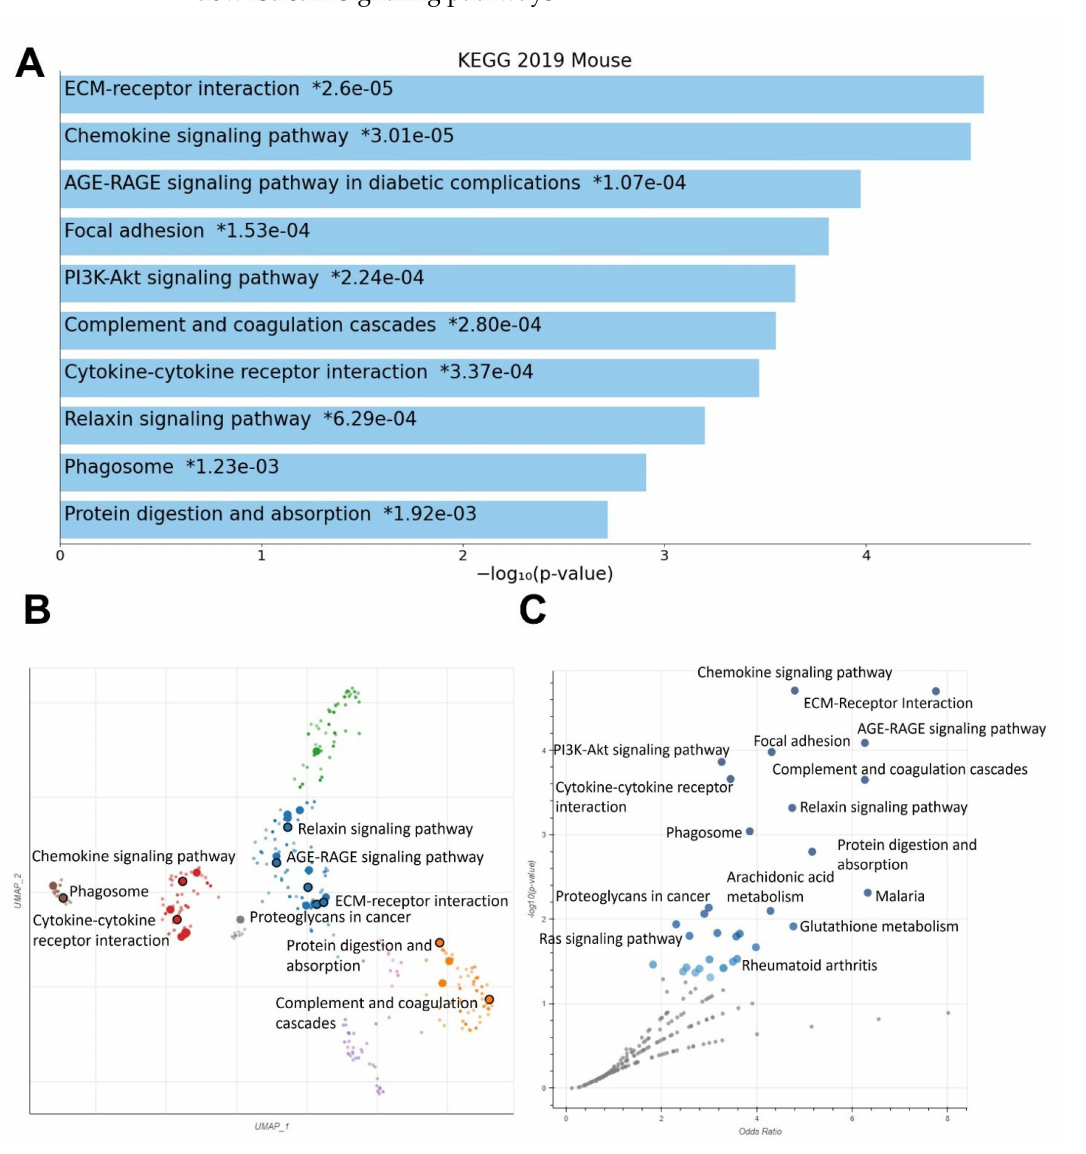
Figure 3. RXR agonists regulate cancer-relevant biological pathways in MMTV-Neu tumors. Female MMTV-Neu mice with established mammary tumors 4 mm in diameter were fed control diet, bexarotene (100 mg/kg in diet), or MSU-42011 (100 mg/kg in diet) for 10 days. KEGG 2019 mouse was used as the database for enrichment analysis of both RXR agonists. ( A ) Bar graph of top differentially expressed pathways. Scatterplot ( B ) and volcano plot ( C ) of top differentially expressed pathways. * = p